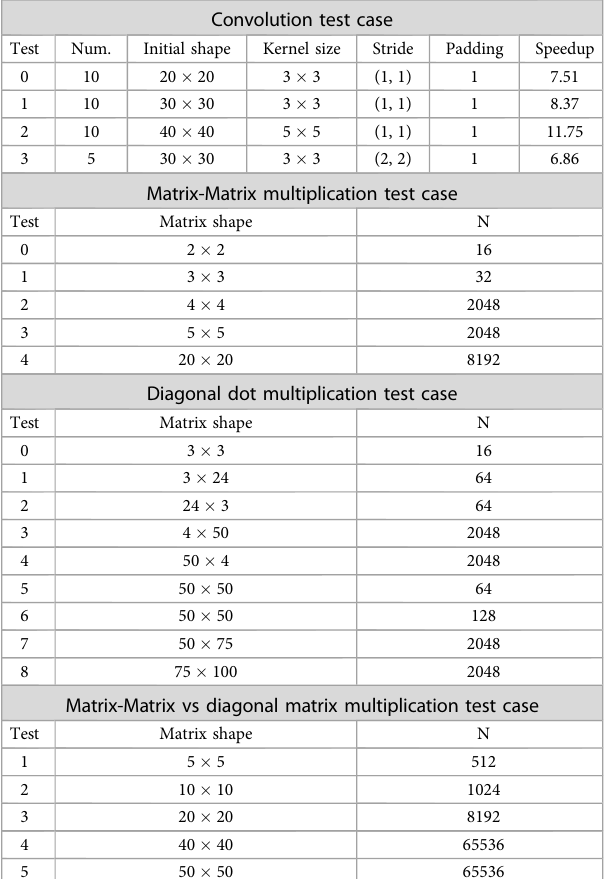
TABLE 4 Parametrization of the different tests performed for each of the four takeaways considered in Subsection